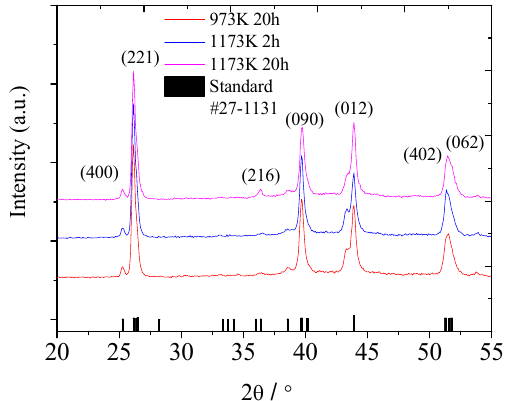
Figure 1. Powder x ‐ ray diffraction (PXRD) patterns for the Cu 2 Se samples sintered under different conditions. (Black bars show the standard PDF card #27–1131 diffraction peak sites).